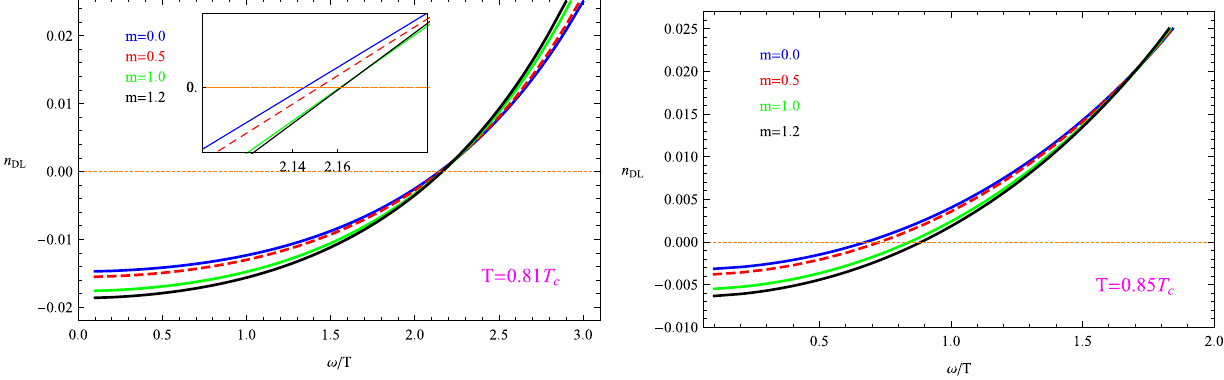
Fig. 5 Depine–Lakhtakia index n DL as a function of ω/ T with the fixed temperatures T = 0 . 81 T c (left) and T = 0 . 85 T c (right) for dif- ferent values of the graviton mass parameter, i.e., m = 0 . 0 (blue), 0 . 5